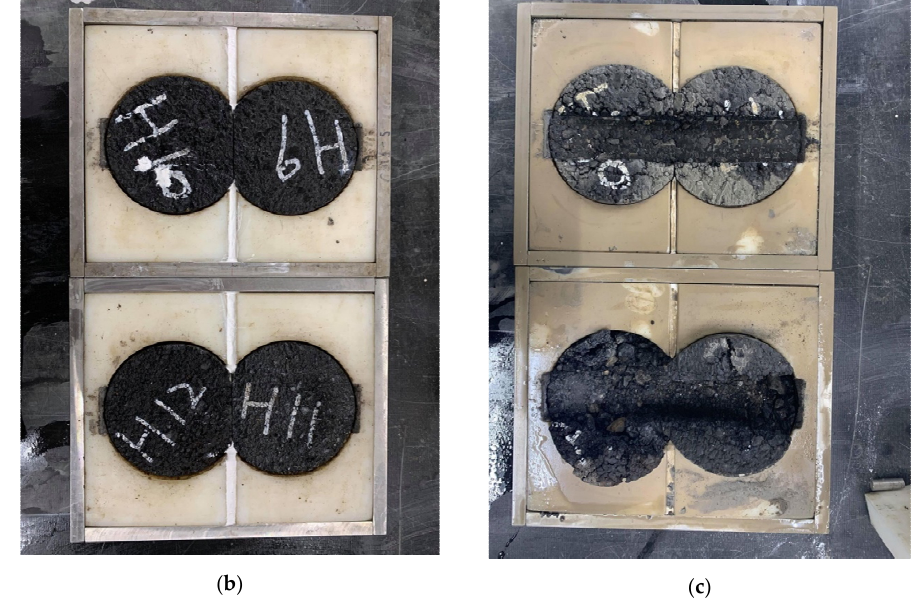
Figure 1. HWTT device and specimens. ( a ) HWTT device; ( b ) before test; ( c ) after test.